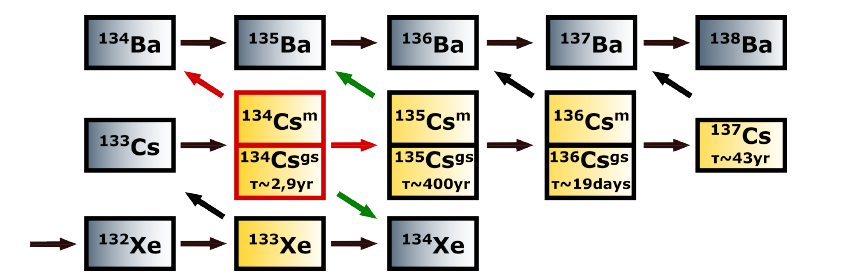
Figure 3. The s-process path trough Cs and Ba isotopes. The stable isotopes are shown in grey boxes, the unstable ones in yellow boxes. The 134 Cs and 135 Cs branching points are highlighted by red arrows.